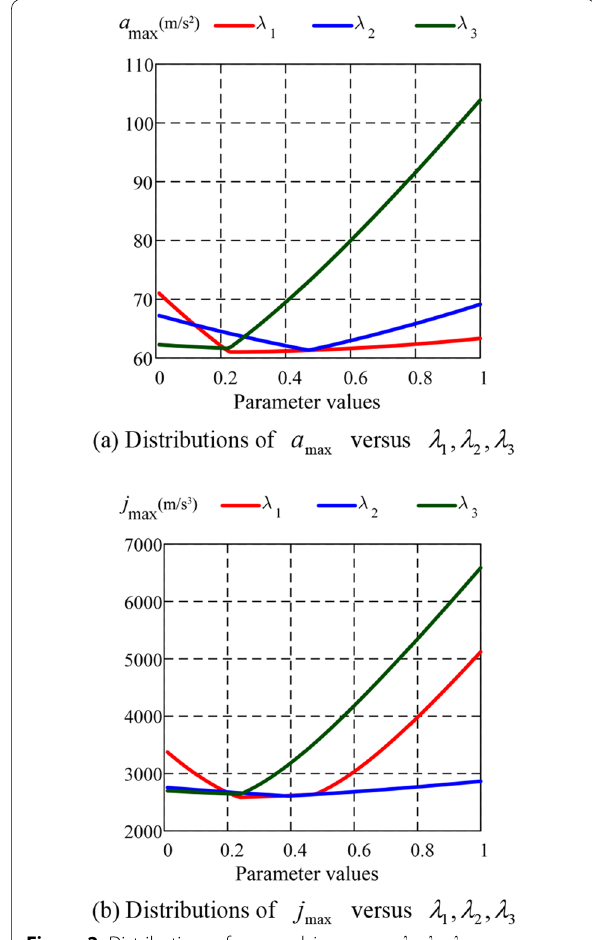
Figure 2 Distributions of a max and j max versus (cid:31) 1 , (cid:31) 2 , (cid:31)